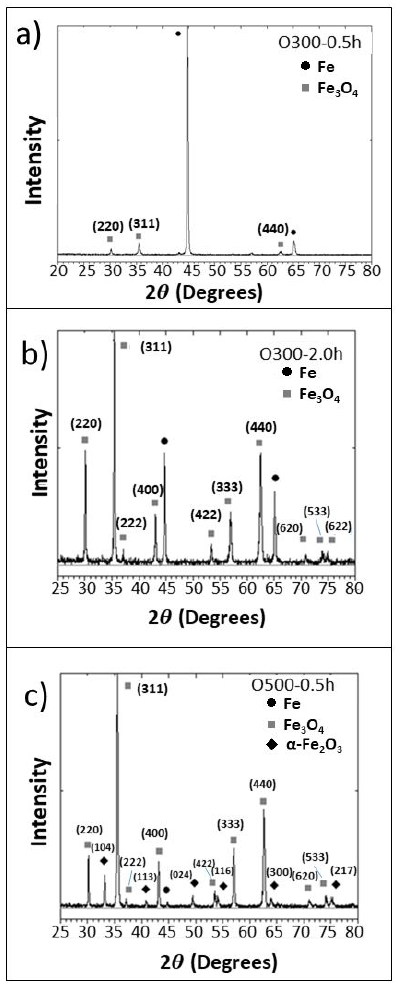
Figure 6. Raman spectroscopy analysis: a) samples O300, b) samples